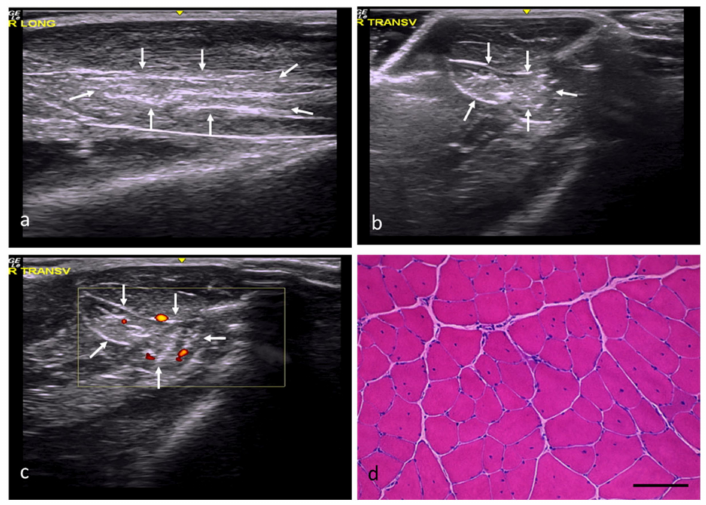
Figure 2. RC group. ( a ) Longitudinal section, with images of a slightly hyperechoic injury com- pared with the adjacent muscle tissue and a distorted fibrillar pattern, demarcated by white arrows. ( b ) Transverse section, with images of an injury with slightly increased echogenicity and poorly defined margins, demarcated by white arrows. ( c ) Transverse section assessed by power Doppler imaging, with images of moderately increased perilesional vascularization. ( d ) Transverse section representative of the muscle histology. H-E. Size scale: 100 µ